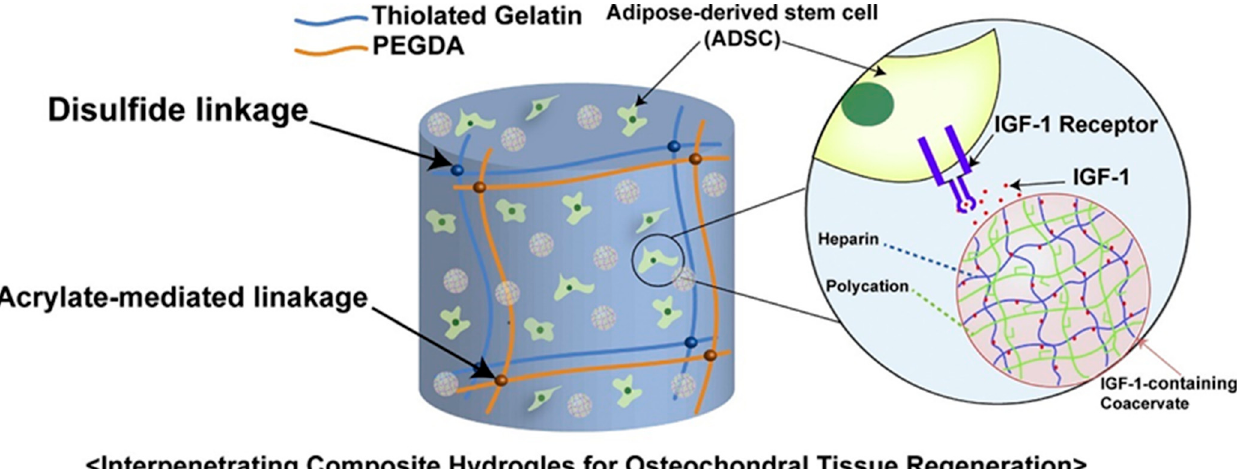
Figure 2. An implantable dual-delivery platform was developed using a tertiary complex of poly(ethylene argininylaspartate diglyceride) (PEAD) polycation, heparin, and cargo insulin-like GF-1 in a thiolated gelatin/PEGDA IPN hydrogel, Reprinted from Ref. [42].